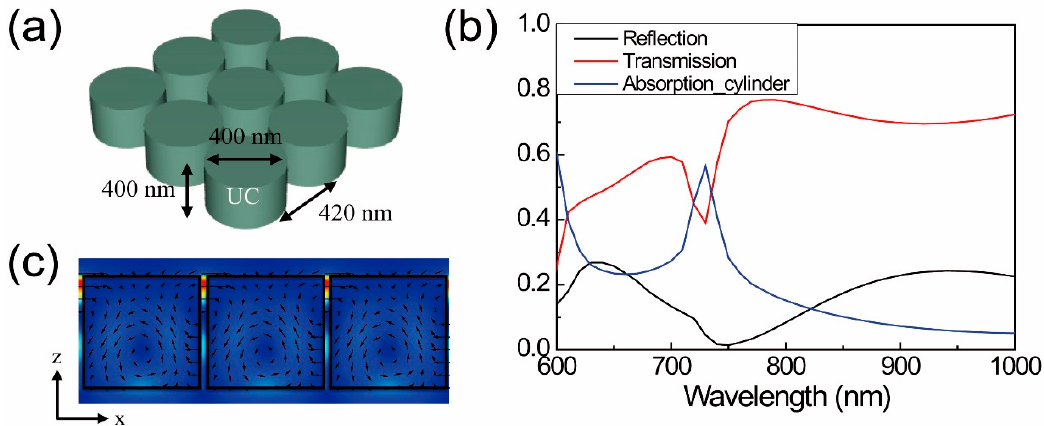
Figure 3. ( a ) Array of UC nanocylinders arranged in a square lattice with a period of 420 nm. The cylinder has a height of 400 nm and a diameter of 400 nm; ( b ) Reflection (black), transmission (red), and absorption curves (blue) as a function of wavelength; ( c ) Electric field intensity profile with a vector field plot in the side view.